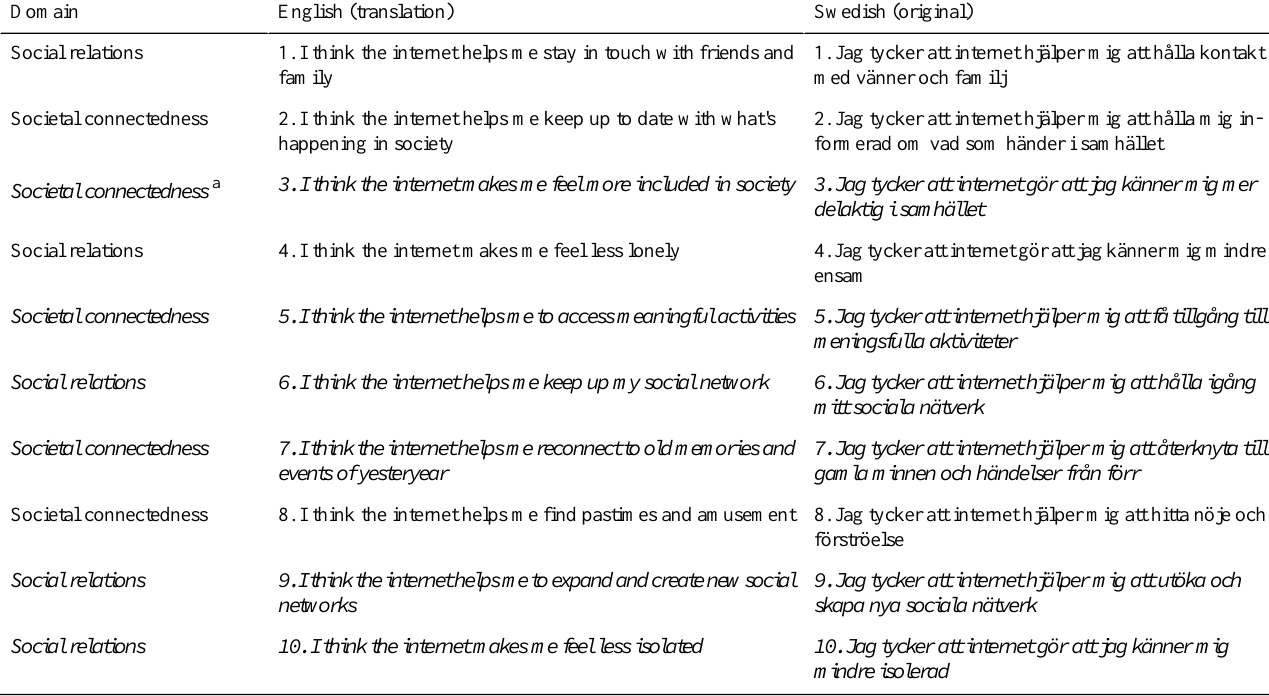
Table 1. Initially suggested 10-question